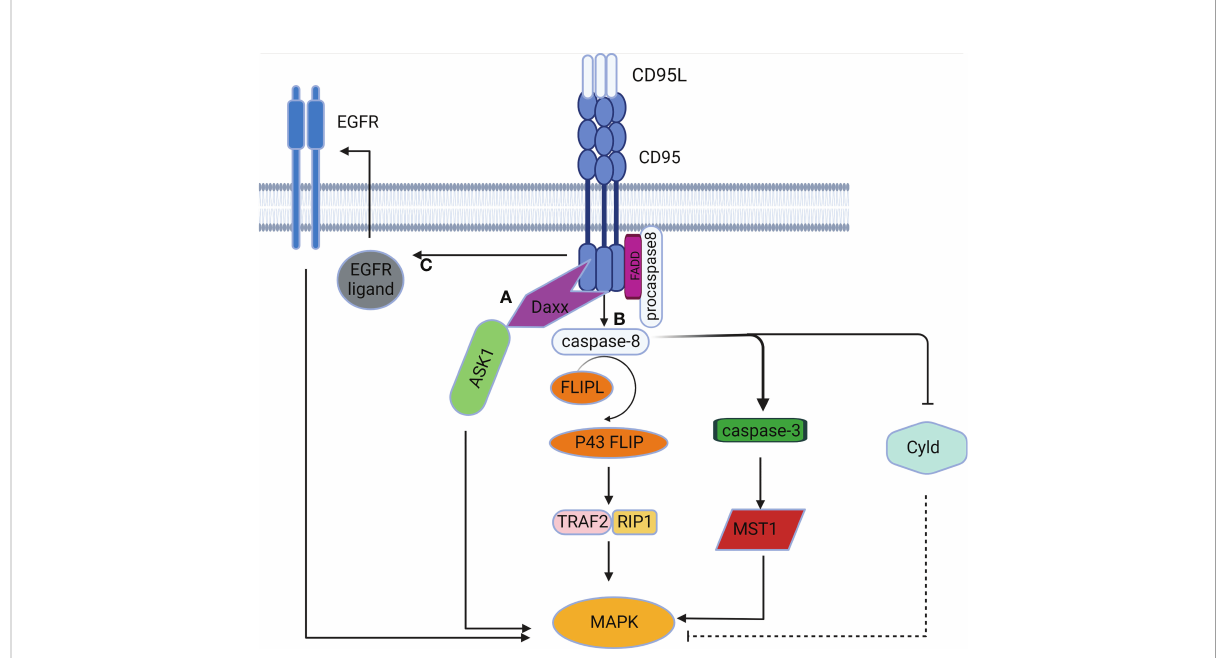
FIGURE 3 The MAPK signaling pathway mediated by CD95. (A) CD95 induces DD-mediated caspase-independent activation of the MAPK pathway. (B) CD95 induces caspase-dependent activation of the MAPK pathway. (C) CD95 induces activation of the MAPK pathway in a DD-independent manner by stimulating